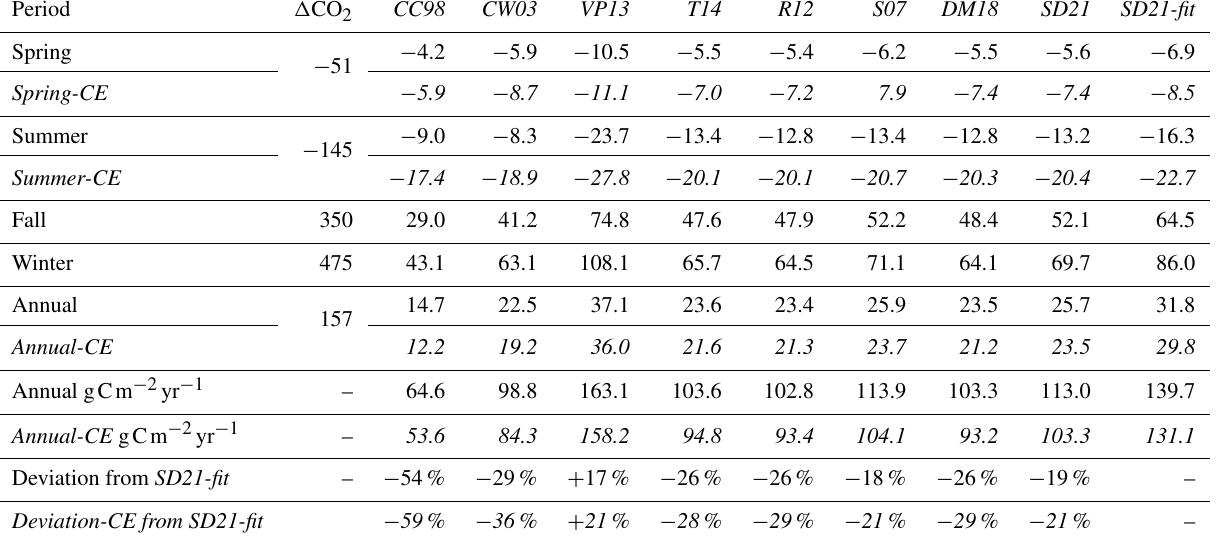
Table 3. Seasonal to annual CO 2 flux estimation (mmolCm − 2 d − 1 ) from k models (with, denoted using “-CE” (italic font), and without (roman font) chemical enhancement), the monthly (cid:49) CO 2 average (µatm), and the models’ deviation from SD21-fit . CE was only considered for seasons when pH >